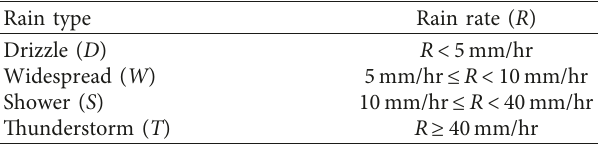
Table 1: Classification of rain